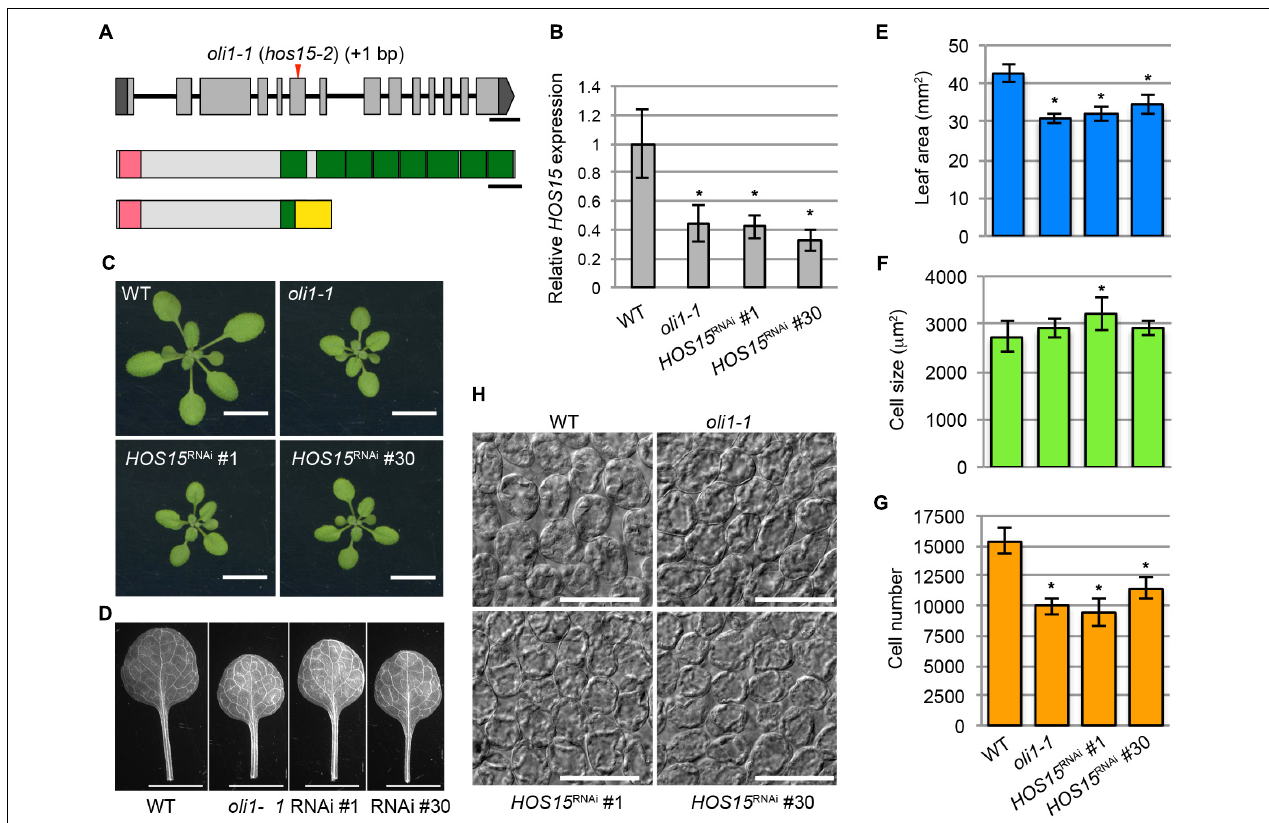
FIGURE 3 | Identification of the causal gene of the oli1-1 mutation. (A) Schematic diagrams of the OLI1 / HOS15 locus (top) and HOS15 protein (middle) and the deduced structure of mutated oli1-1 protein (bottom). The mutation point of oli1-1 (renamed hos15-2 ) is indicated by a red arrowhead. Exons and introns are indicated by boxes and lines, respectively. The 5 (cid:48) - and 3 (cid:48) -untranslated regions of OLI1 / HOS15 are indicated in dark gray, while the coding regions are indicated in light gray. The amino-terminal LisH motifs are indicated by pink boxes, while the carboxy-terminal WD40 repeats are indicated by green boxes. A yellow box indicates the region generated due to the frame shift by the oli1-1 mutation. Bars indicate 300 bp and 50 amino acids, respectively. (B–G) Characterization of HOS15 knockdown plants by RNAi ( HOS15 RNAi No. 1 and No. 30). (B) Expression levels of HOS15 determined by RT-qPCR using 10-day-old shoots. Data are shown as means ± SD. Asterisks indicate statistically significant differences compared with the WT value ( n = 3, Student’s t -test, p < 0.05). (C) Shoots. (D) First leaves. (E) Areas of the first leaves. (F) Projection area of the palisade cells. (G) Estimated palisade cell numbers. (H) Palisade cells observed from the paradermal view. In (C–H) , 21-day-old plants were used. In (E–G) , the data are shown as means ± SD ( n = 10), and the asterisks indicate significant differences compared with the WT values (Student’s t -test; p < 0.05). The bars in (C) , (D) , and (H) indicate 1 cm, 5 mm, and 100 µ m,